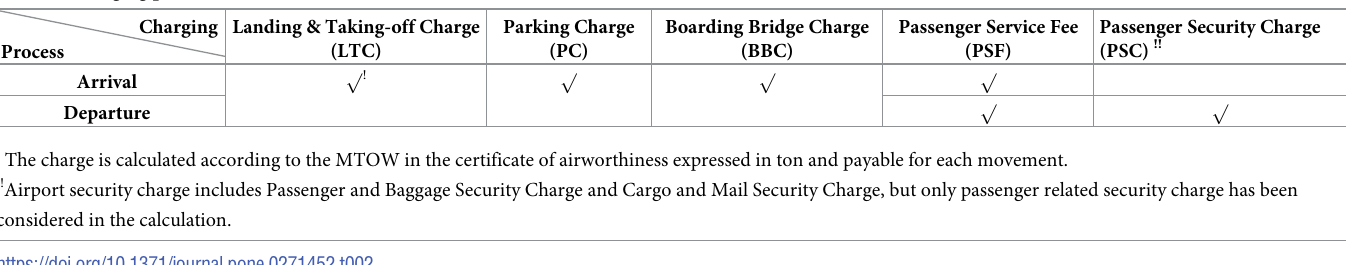
Table 2. Charging process in HGH.